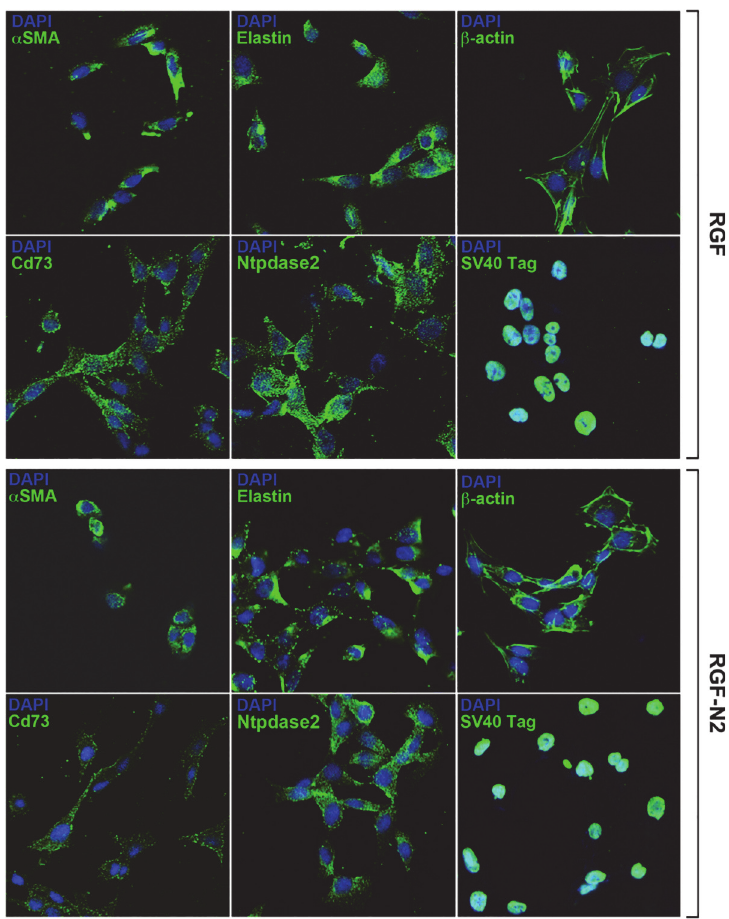
Fig 3. Phenotypic characterization of immortalized rat portal fibroblastic RGF and RGF-N2 cell lines by immunofluorescence. Immortalized RGF cells were fixed, stained with antibodies to proteins specifically expressed in PF-derived myofibroblasts, and counterstained with DAPI nuclear labeling dye. RGF cells express myofibroblast-specific α SMA and Cd73 proteins, PF-specific elastin and Ntpdase2 proteins, β -actin protein and SV40 antigen. Immortalized RGF-N2 cells were fixed, stained with the same antibodies, and counterstained with DAPI dye, as described above for RGF cells. Like RGF cells, RGF-N2 cells express α SMA, Cd73, Elastin, Ntpdase2, β -actin, and SV40 antigen. 400X magnification